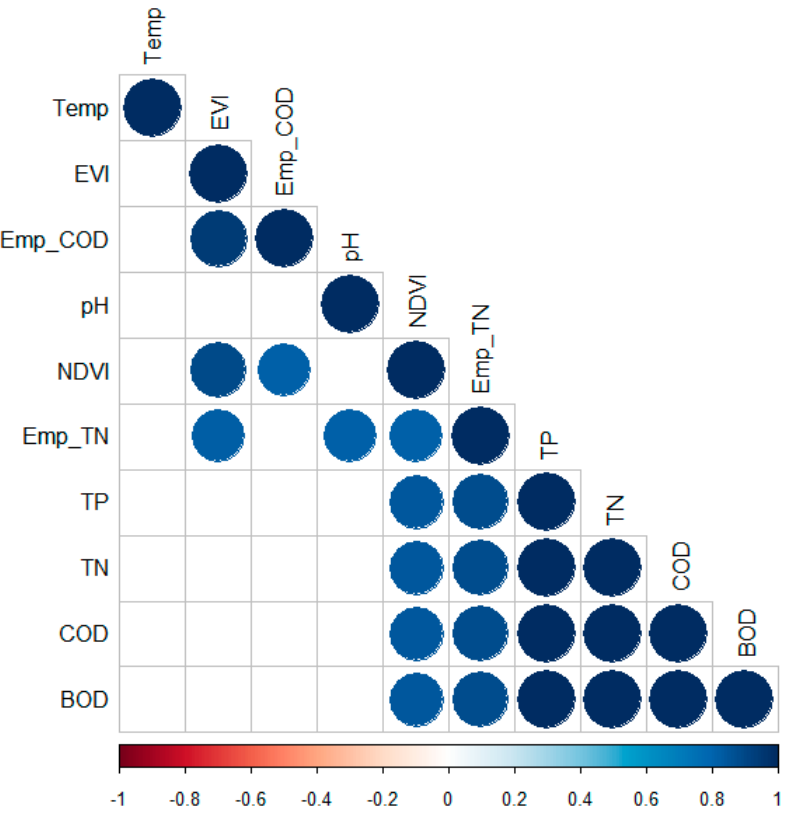
Figure 4. Correlation heatmap matrix of indicators of water quality in the Cascajo Wetlands. The significance levels of the Pearson correlation are 0.05. Blank means no significant coefficient. The blue number represents a positive correlation, while the red number demonstrates a negative correlation. Chemical oxygen demand (COD); biological oxygen demand (BOD); total nitrogen (TN), and total phosphate (TP), Normalized Difference Vegetation Index (NDVI); Enhanced Vegetation Index (EVI); empirical COD (Emp_COD), empirical TN (Emp_TN).